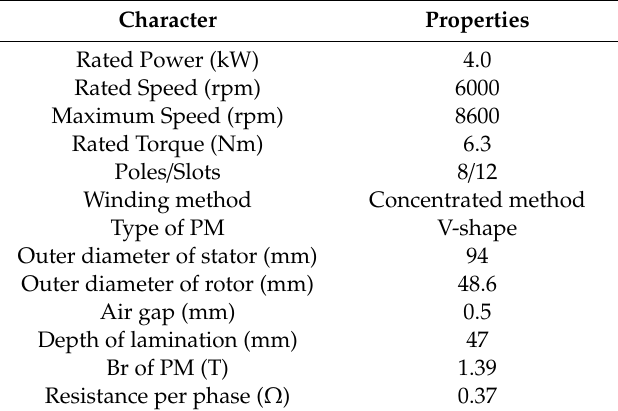
Table 1. Properties of interior permanent magnet (IPM)